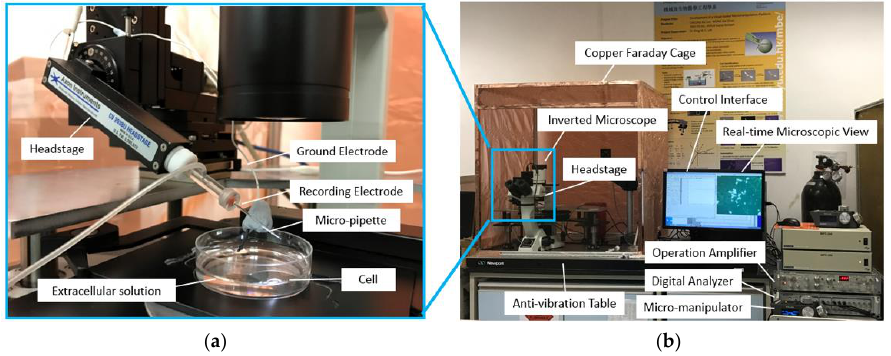
Figure 4 . The experimental setup of the current feedback injection: ( a ) the close-up view; ( b ) the overal view.